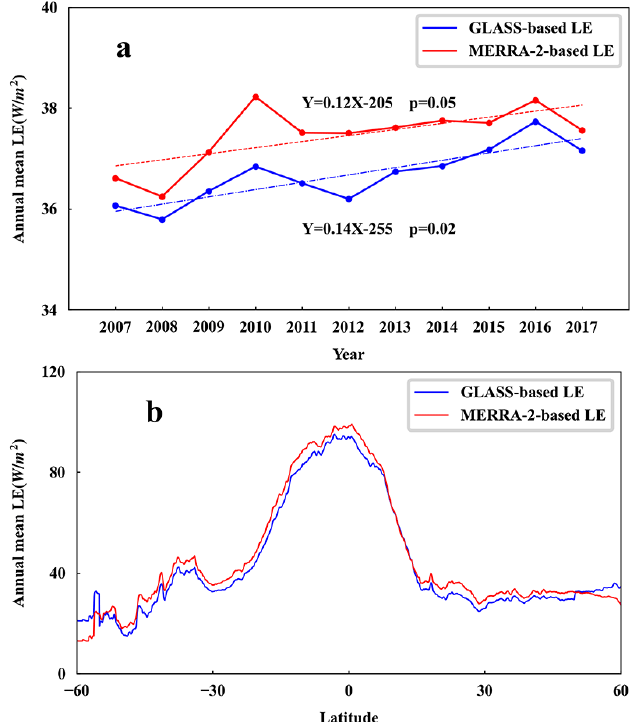
Figure 9. Trends in globally-averaged annual LE ( a ) and latitude series of average LE ( b ) based on the two Rn products during the period 2007–2017.